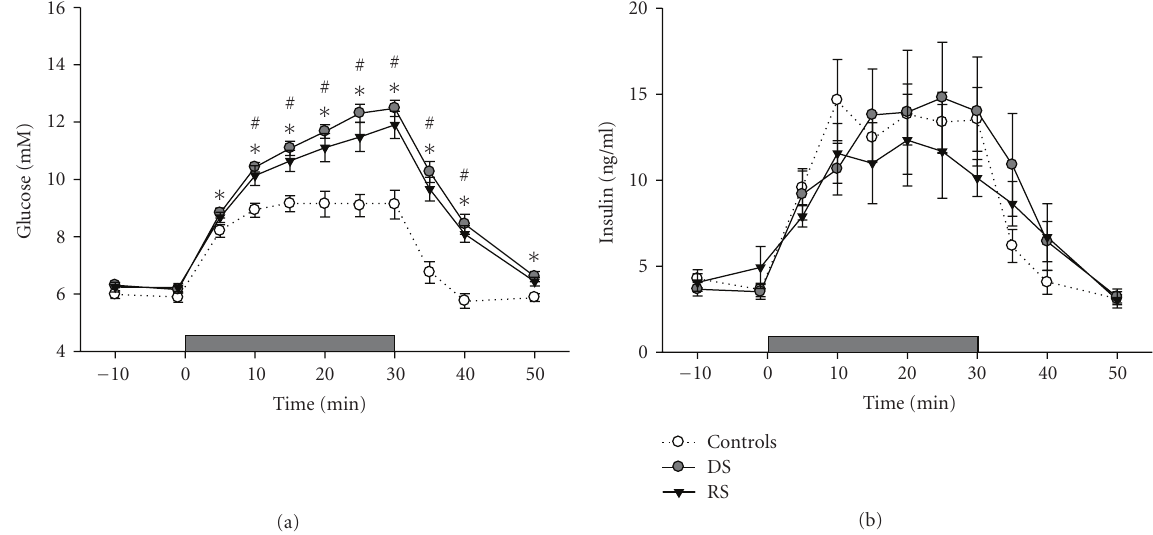
Figure 4: Blood glucose (a) and plasma insulin levels (b) in response to a 30-minutes intravenous glucose infusion after 1 day of sleep restriction (closed triangles, n = 8), sleep disturbance (closed circles, n = 8), or control (open circles, n = 8). The horizontal grey bars at the bottom of the graphs represent the 30 minutes of 15% glucose infusion. Data are average values ± SEM. Asterisks indicate a significant di ff erence between sleep restricted rats and controls ( ∗ P < .05) and # indicates a significant di ff erence between sleep disturbed rats and controls ( # P <